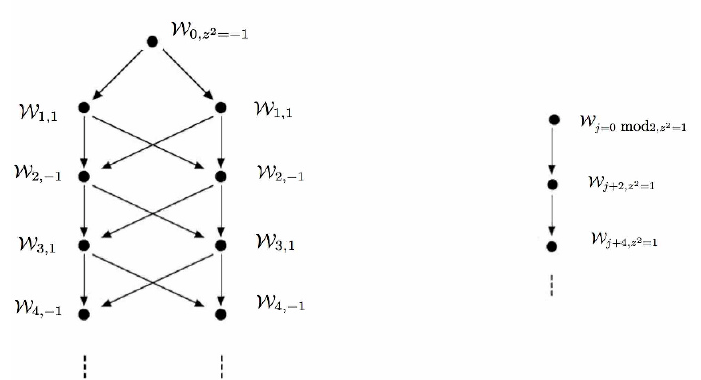
Figure 12 . Structure of standard modules for q = e i(cid:25)= 2